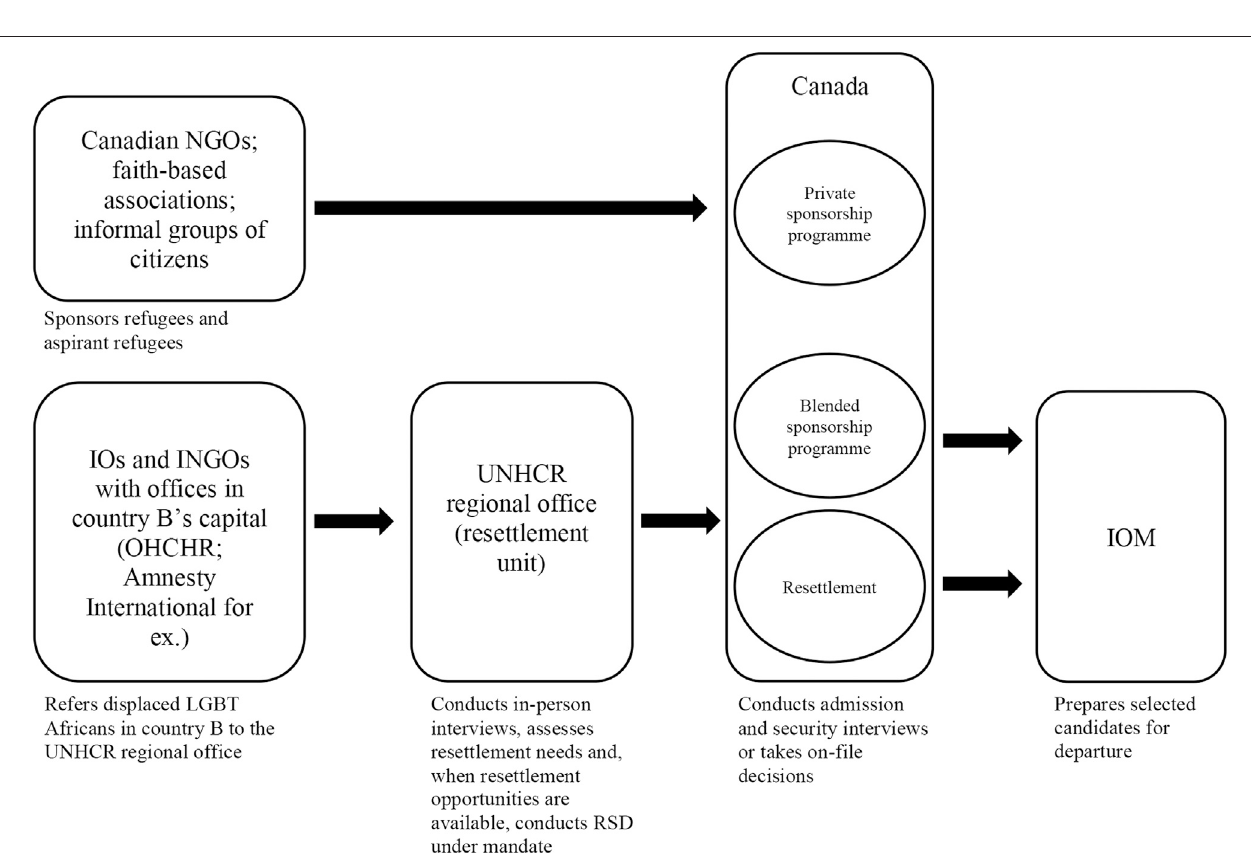
FIGURE 2 | Process of refugee selection for LGBT resettlement and complementary pathways from country B, based on fi eldwork insights.